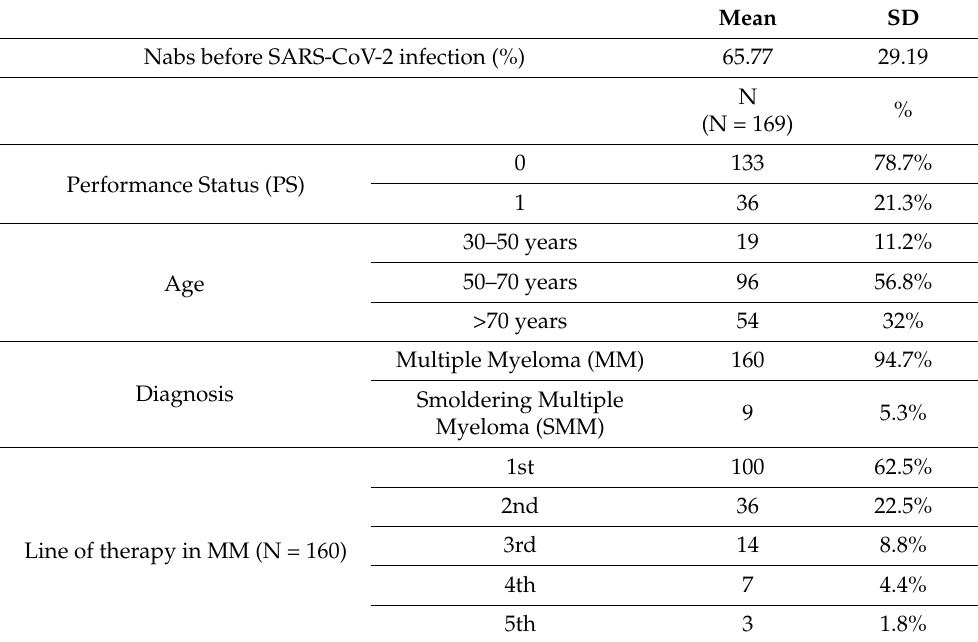
Table 1. Patients’ characteristics before SARS-CoV-2 infection.